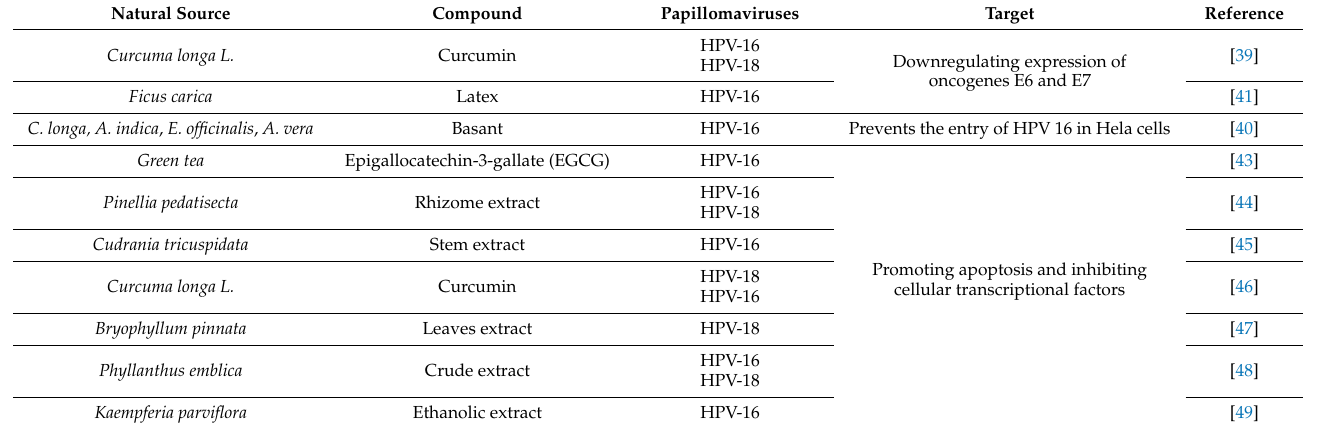
Table 3. Natural compounds and their antiviral targets against